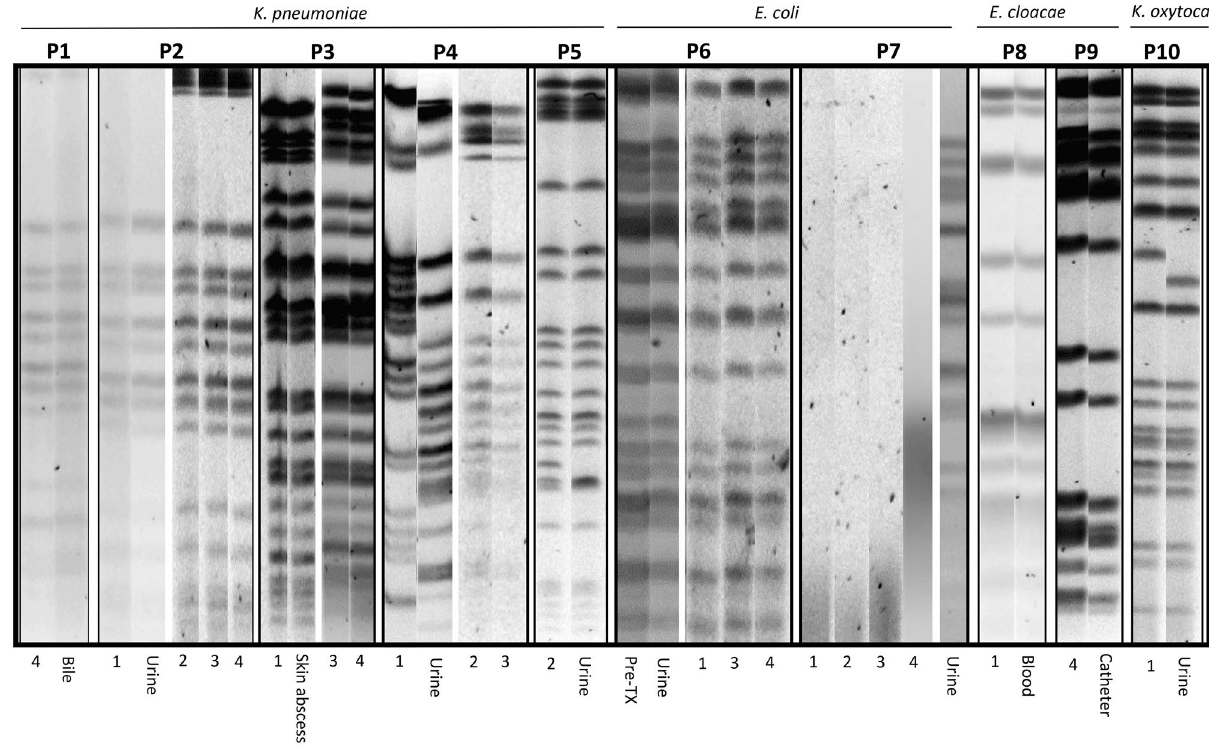
Figure 1. PFGE patterns of MDR-E from rectal swabs obtained pre-transplant (pre-TX) or post-transplant (number indicates weeks for rectal swabs) and from infection-related strains in 10 transplant recipients (P1 to P10 corresponding to Table 5). The PFGE profiles were obtained from different agarose gels and grouped in this figure. (P7: isolates 1, 2, 3 and 4 were non-typeable with Xba